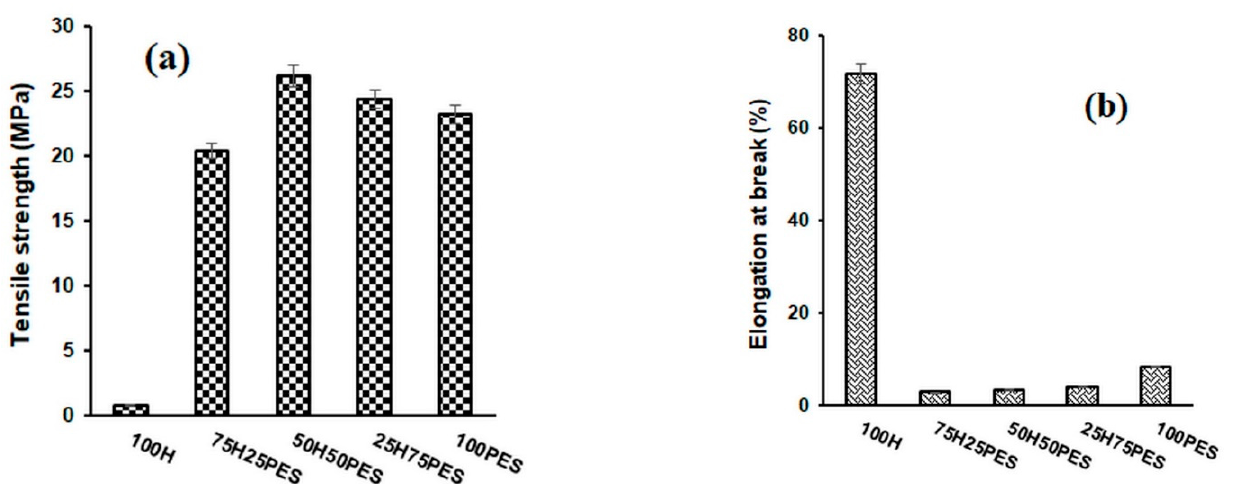
Figure 2. Variation in tensile strength ( a ) and elongation at break ( b ) for hemp composites and bicomponent fibres.